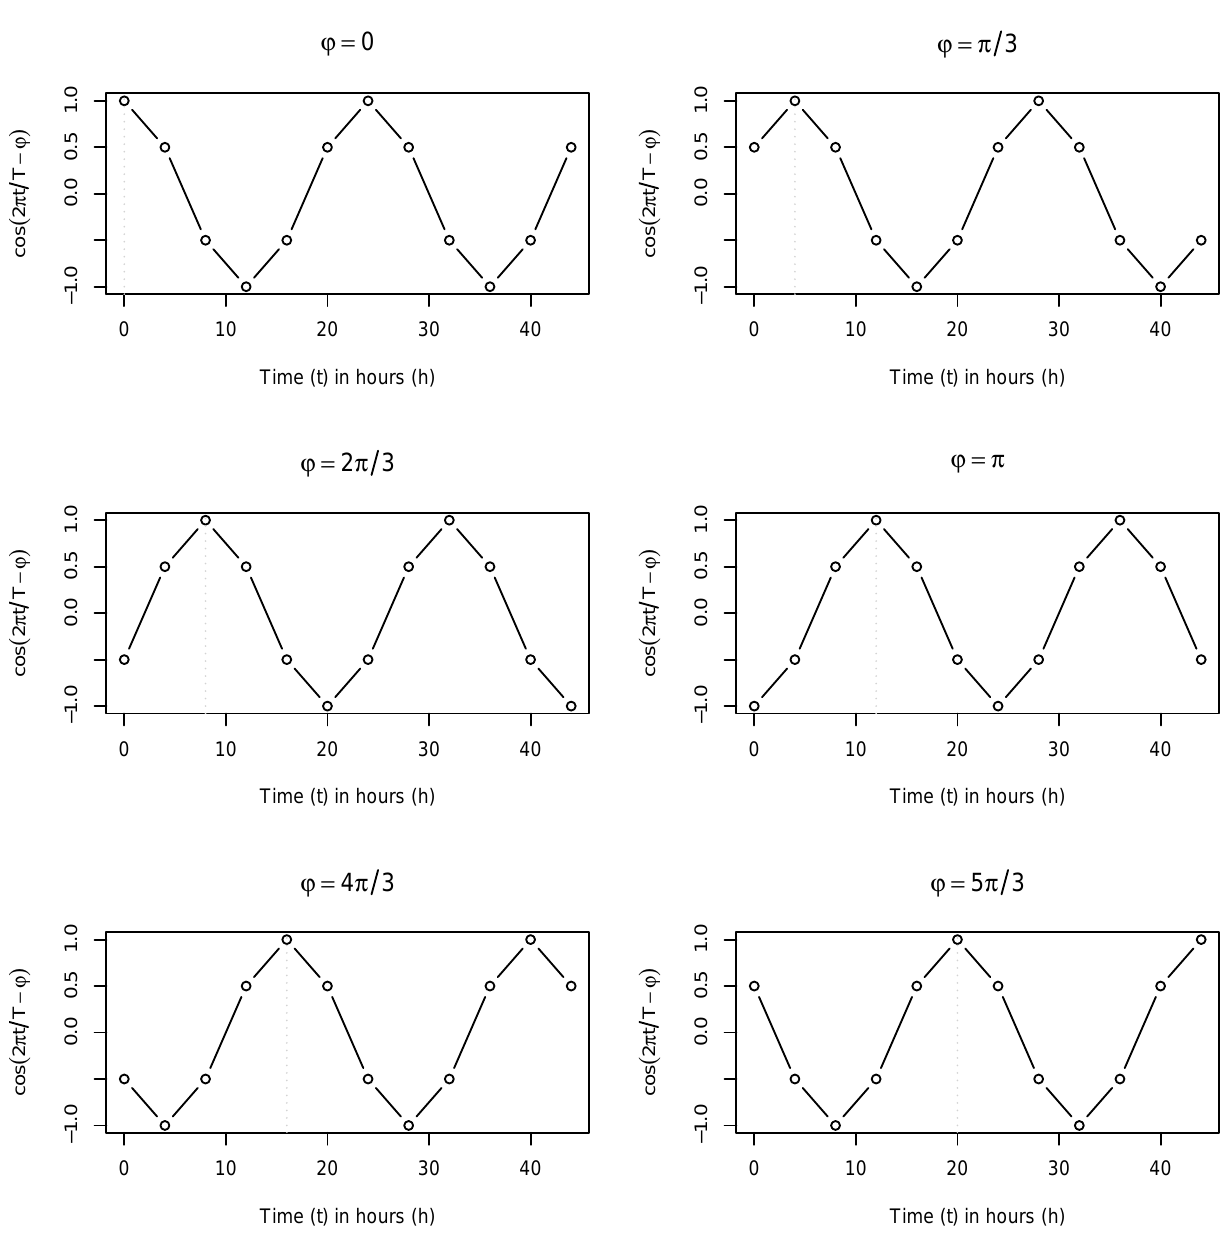
t (cid:3) φ Þ for t = 0,4,8, ... , 44 and φ 2 {0, π /3, 2 π /3, π , 5 π /3}. The dotted vertical T